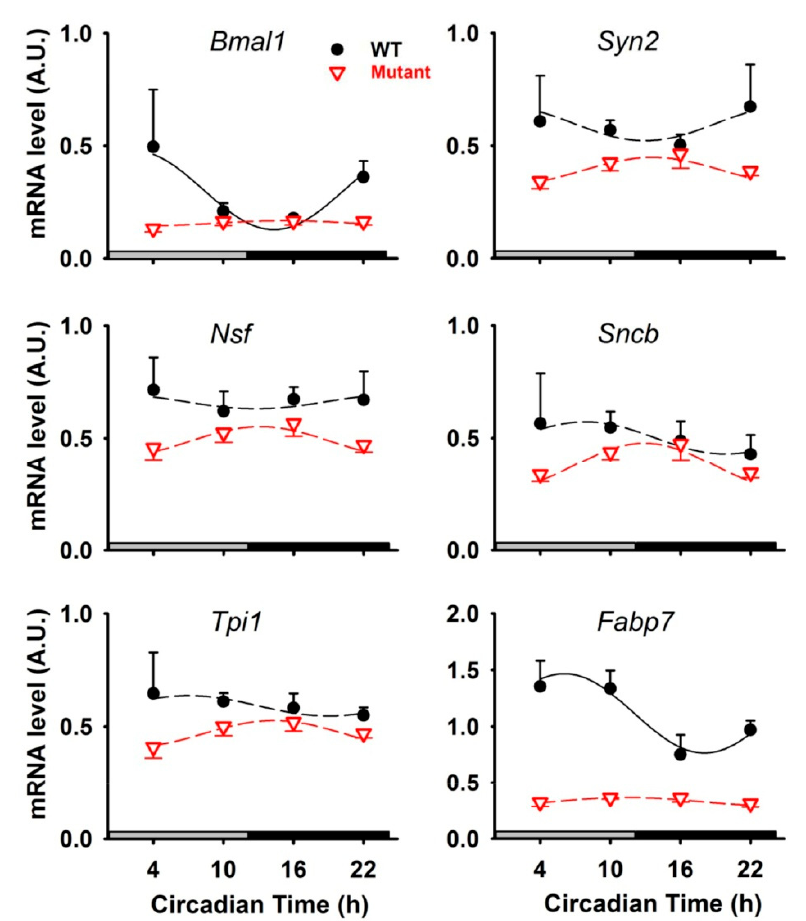
Figure 5. Circadian expression of genes in the cerebellum of wild-type (WT, black curves) and Per1 - / - / Per2 Brdm1 mutant mice (Mutant, red curves). Fitted solid and dashed curves represent significant and non-significant cosinor regressions, respectively. Data are presented as means ± SEM. A.U., arbitrary unit. Bmal1 , Brain and Muscle Aryl-hydrocarbon receptor nuclear translocator-like protein 1; Syn2 , Synapsin 2; Nsf , Vesicle-fusing ATPase; Sncb , β -synuclein; Tpi1 , Triosephosphate isomerase 1; Fabp7 , Fatty acid binding protein 7.